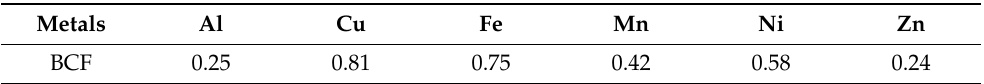
Table 1. Bio-concentration factor of the metals of concern for Vetiveria